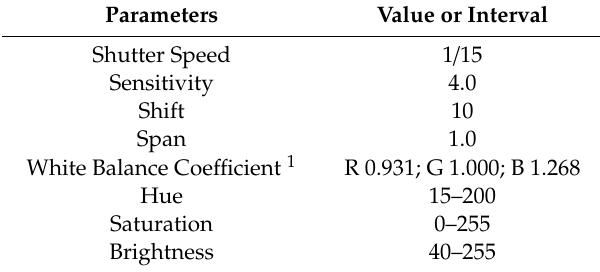
Table 1. Camera and image parameters used for red colour